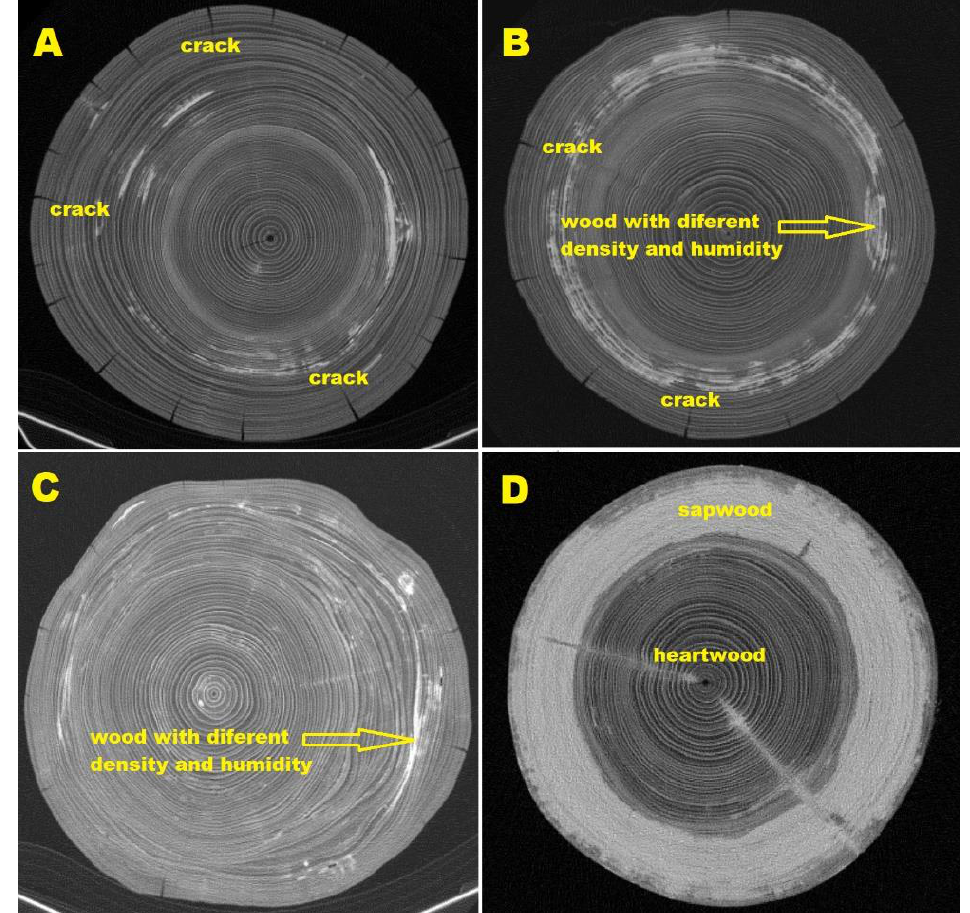
Figure 2. Spruce wood scanned by CT: ( A ) 3 — infested in spring 2018; ( B ) 2 — infested in spring 2019; ( C ) 1 — infested in spring 2020; ( D ) 0 — living tree.